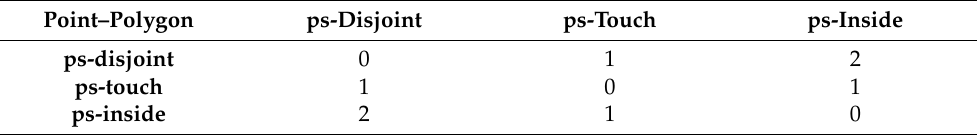
Figure 8. Conceptual neighborhood diagram of topological relations between a point and a polygon. Table 4. Topological relation distances between a point and a